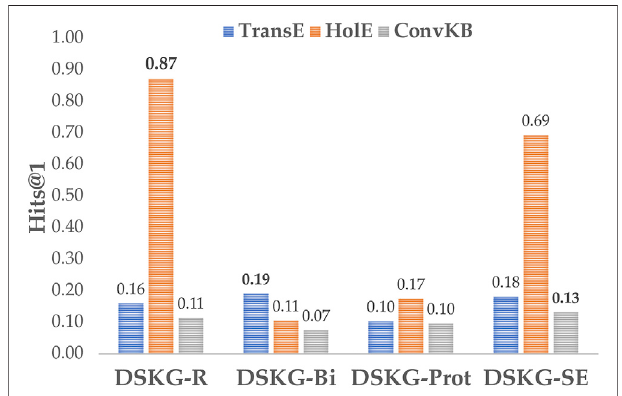
FIGURE 7 | Hits@1 variation of KGE algorithms over different KG